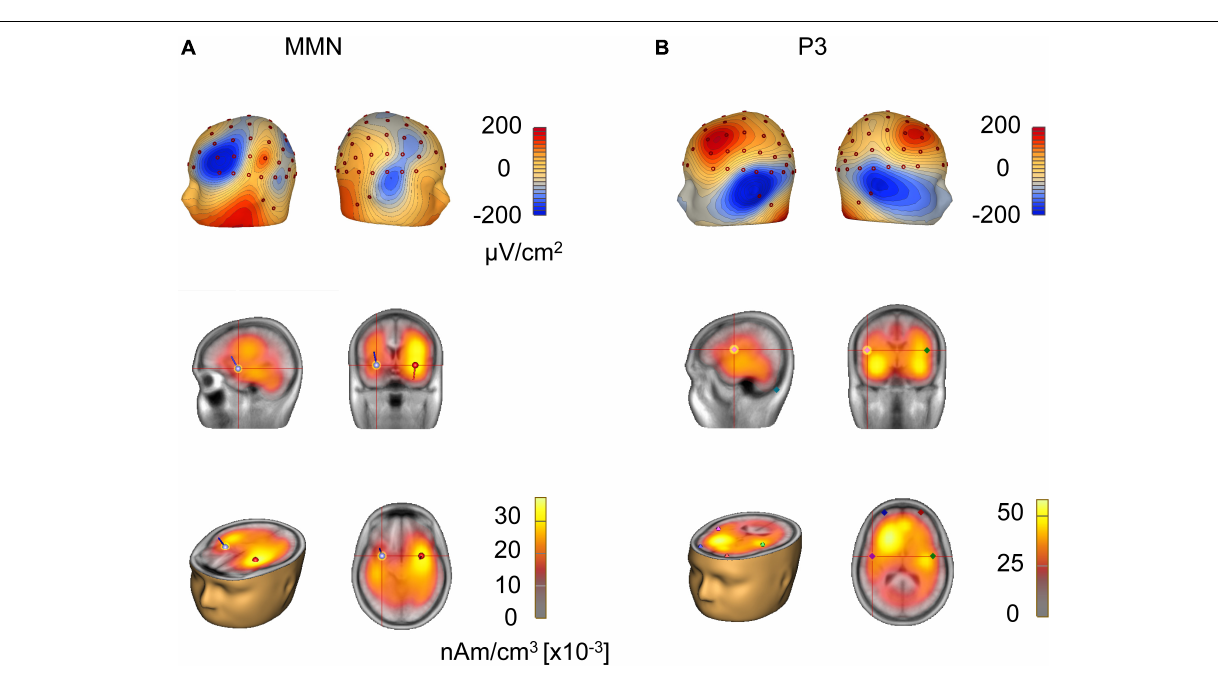
FIGURE 4 | Source analysis of MMN and P3. (A) Current source density topography at the peak of global field power of grand-averaged MMN in response to tone pairs of four-pitch interval. Source localization estimated by local autoregressive average and dipole solution of MMN in response to tone pairs of four-pitch interval. (B) Current source density topography at the peak of global field power of grand-averaged P3 in response to tone pairs of four-pitch interval. Source localization estimated by local autoregressive average and dipole solution of P3 in response to tone pairs of four-pitch